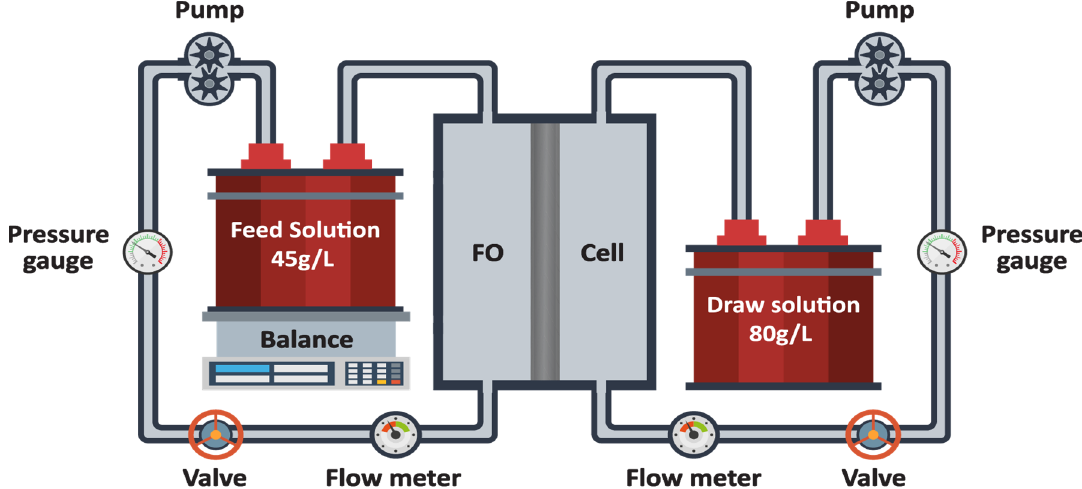
Figure 3. FO bench-scale unit configuration used in the FO experiments.